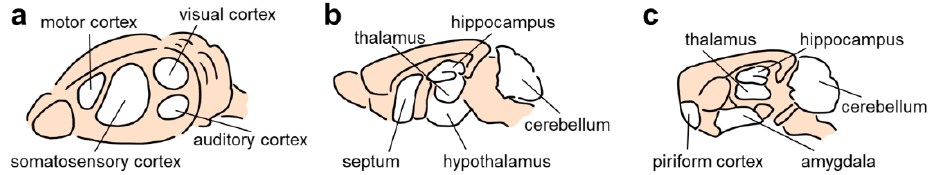
Figure 2. Regions that can be targeted using in utero electroporation. ( a ) Diagonal view of the rodent brain from the surface. ( b ) Sagittal section of the medial part of the rodent brain. ( c ) Sagittal section of the lateral part of the rodent brain.